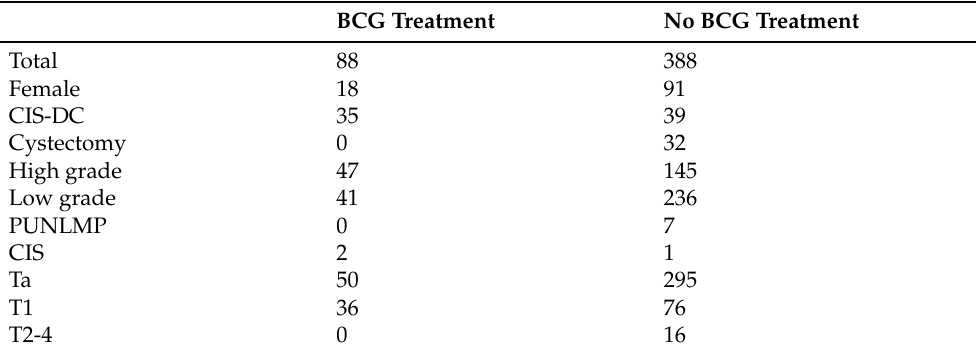
Table A4. Dataset characteristics per BCG treatment (yes/no). BCG—Bacillus Calmette–Guérin vaccine. PUNLMP—papillary urothelial neoplasm of low-malignant potential. CIS—carcinoma